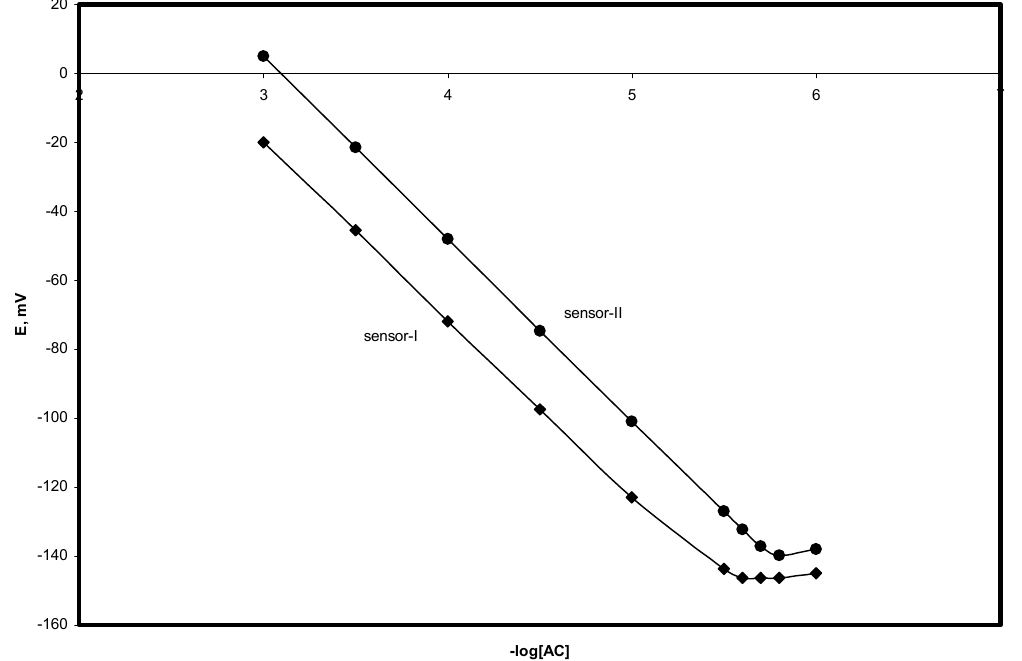
Figure 4. Calibration graph of acebutolol using AC-TPB (sensor-I) and AC-PM